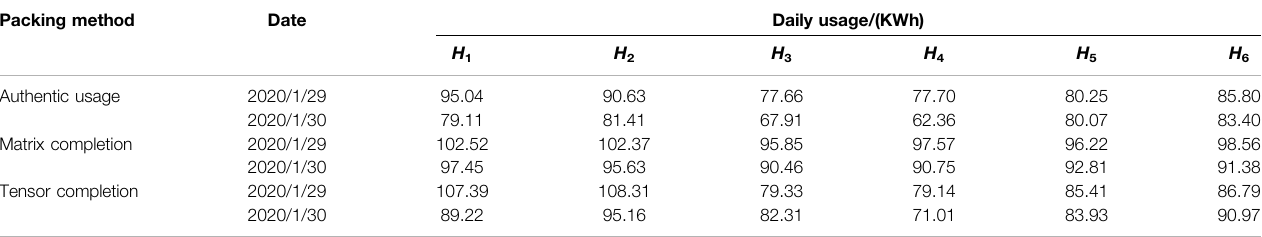
TABLE 6 | Recovered electricity usage of each anomaly user.